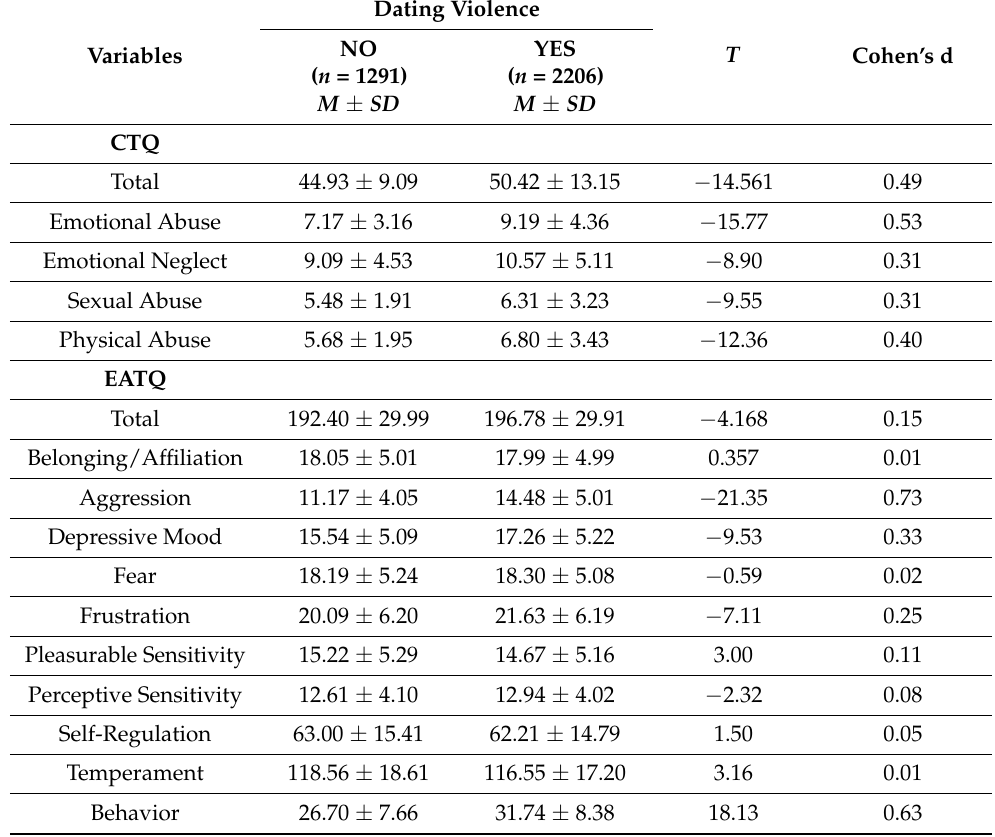
Table 1. Group Differences for Childhood Trauma and Temperament in Dating Violence.